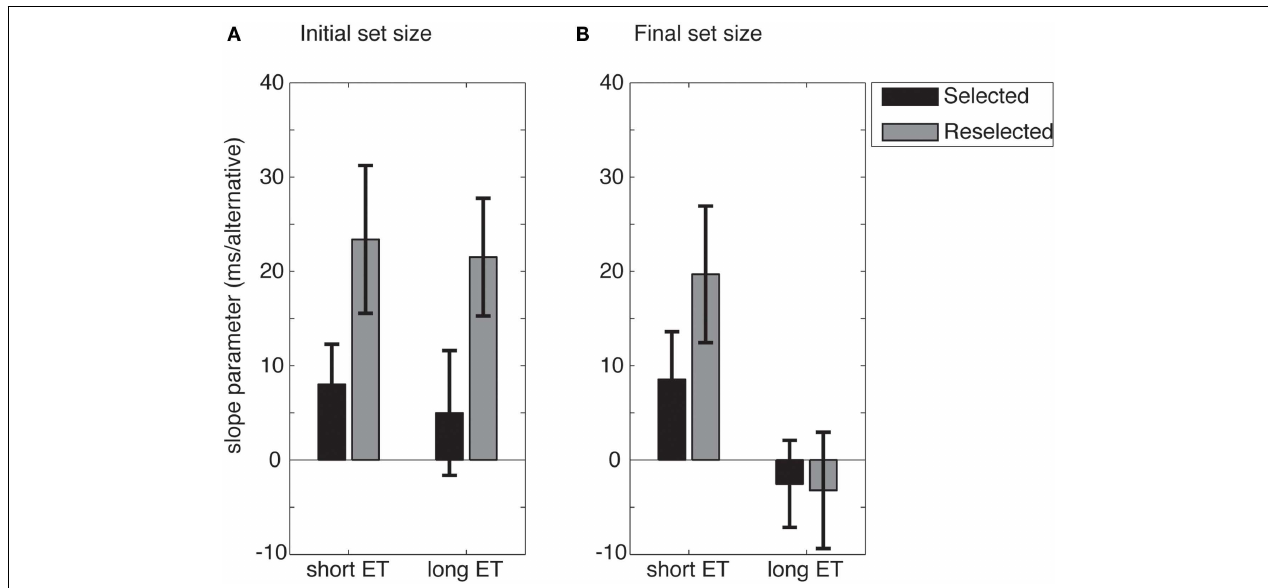
FIGURE 6 | Mean slope of the linear fit to the RTs as a function of response set size, for either initial (A) or final response set sizes (B). For long exposure time (ET) trials, RTs increase as a function of the initial, but not the final, response set size. Error bars show standard error.